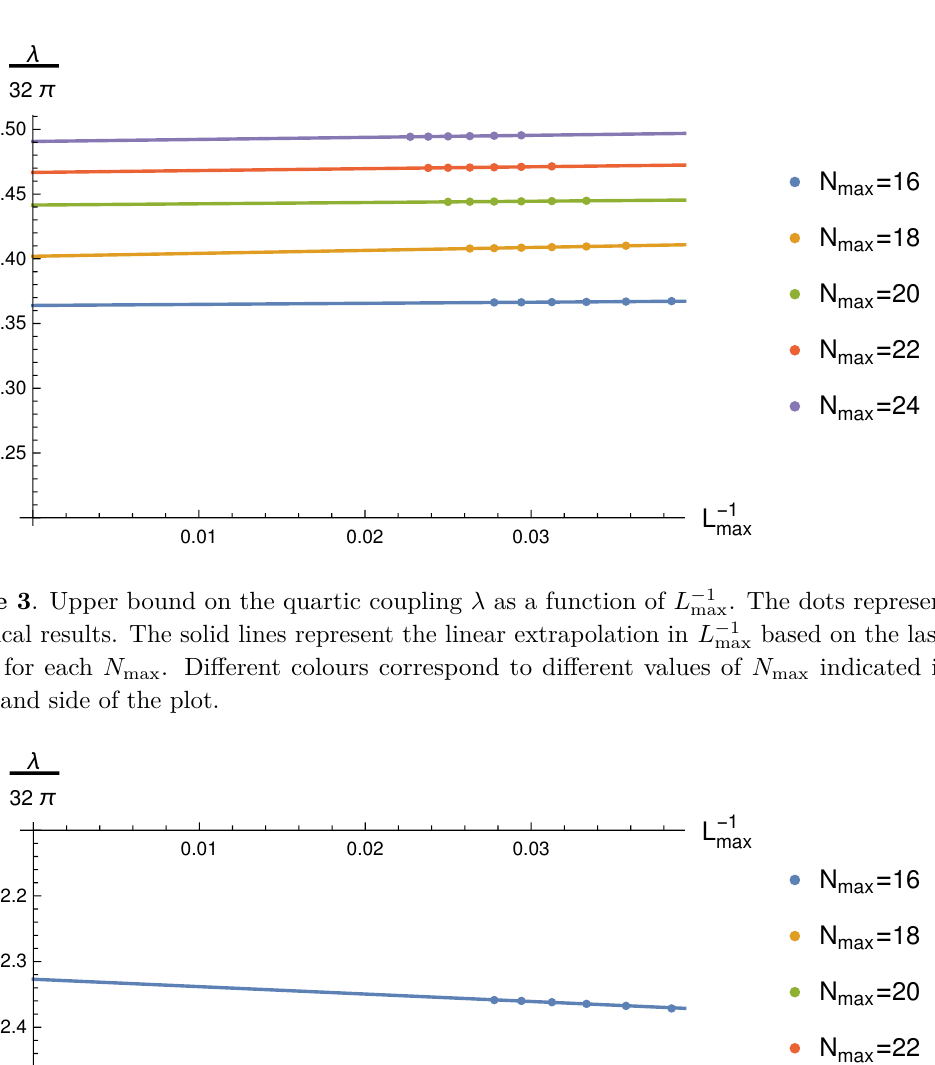
. The dots represent the max based on the last four max